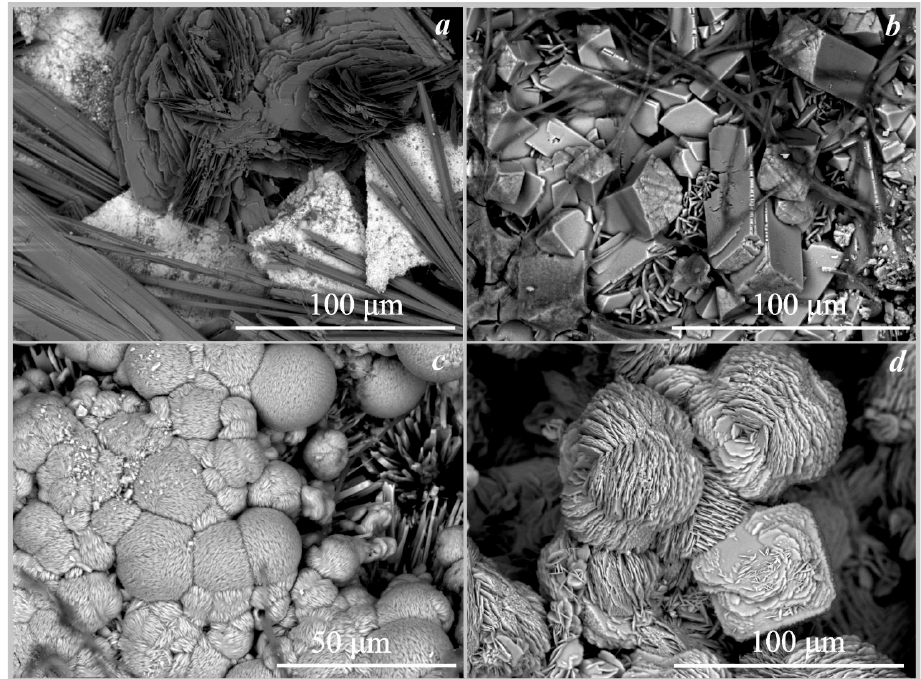
Figure 7. SEM images of the oxalate crystals ( a )—falottaite and lindbergite on hollandite formed under the action of Coniophora puteana ; ( b )—humboldtine, whewellite on siderite formed under the action of Antrodia xantha ; ( c )—moolooite on synthetic malachite formed under the action of Antro- dia xantha ; ( d )—moolooite on synthetic malachite formed under the action of Coniophora puteana .